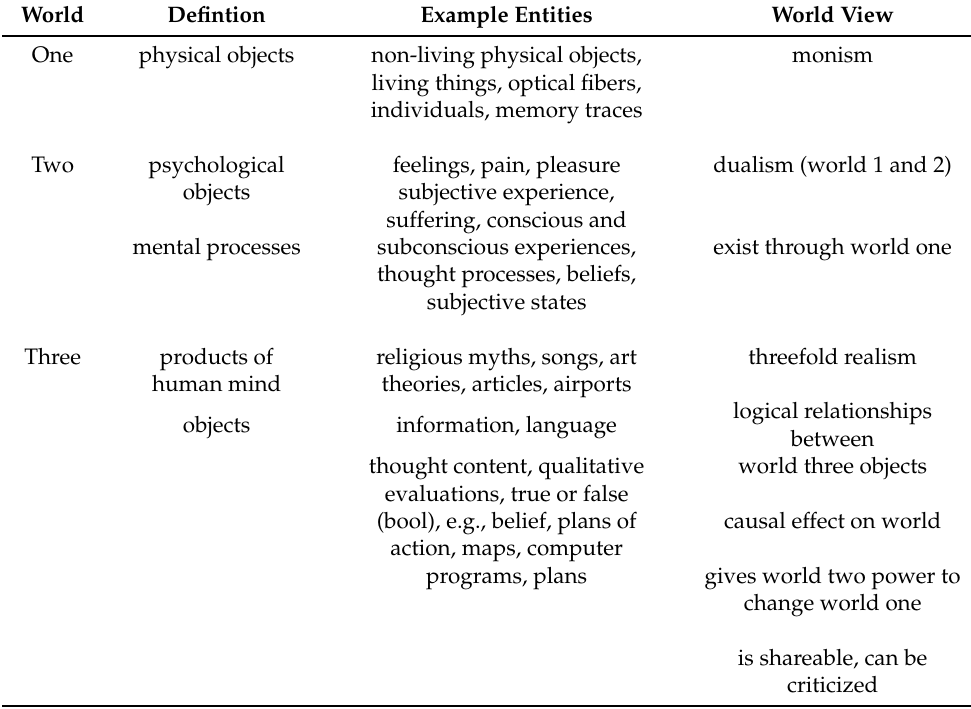
Table 1. Popper’s three ontological